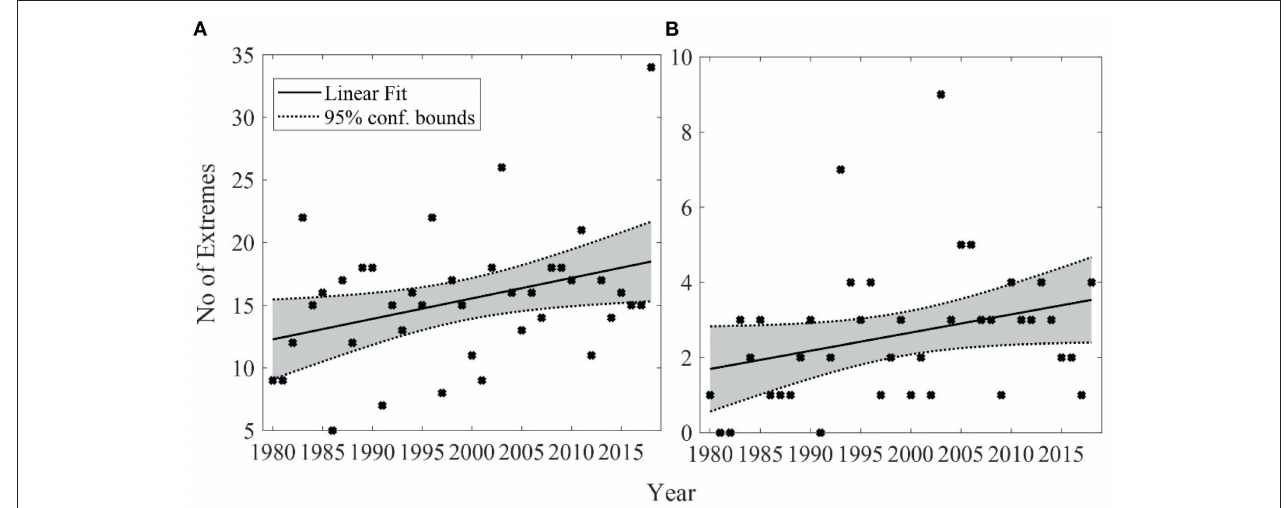
FIGURE 5 | Linear trend in the number of days with precipitation rates above the (A) 95 th and (B) 99 th percentile. The 95 th and 99 th percentiles are calculated at each grid during 1980–2018. The threshold used in the figure is the sub-regional mean derived by averaging the 95 th and 99 th percentiles across all the gird points from Figures 2A,B (i.e., 16.5 and 34.7 mm/day, for the 95 th and 99 th , respectively). Cross markers represent the observed precipitation values for each year, and the fitted least square regression line is shown as a solid black line. Dotted lines indicate the upper and lower 95% confidence bounds of the regression model.